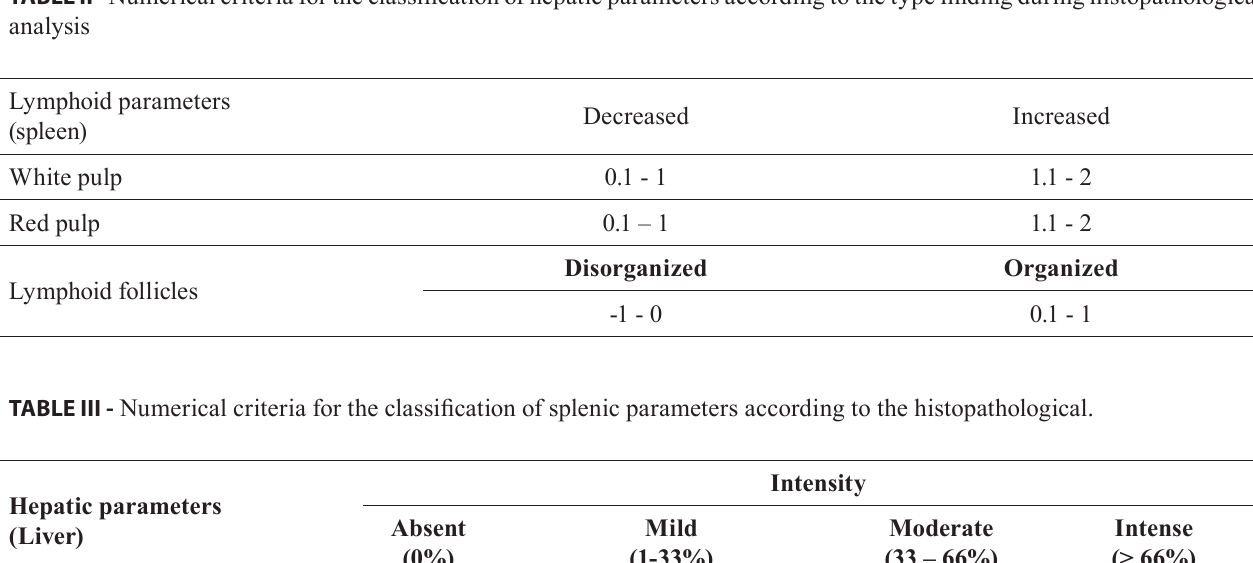
TABLE II - Numerical criteria for the classification of hepatic parameters according to the type finding during histopathological